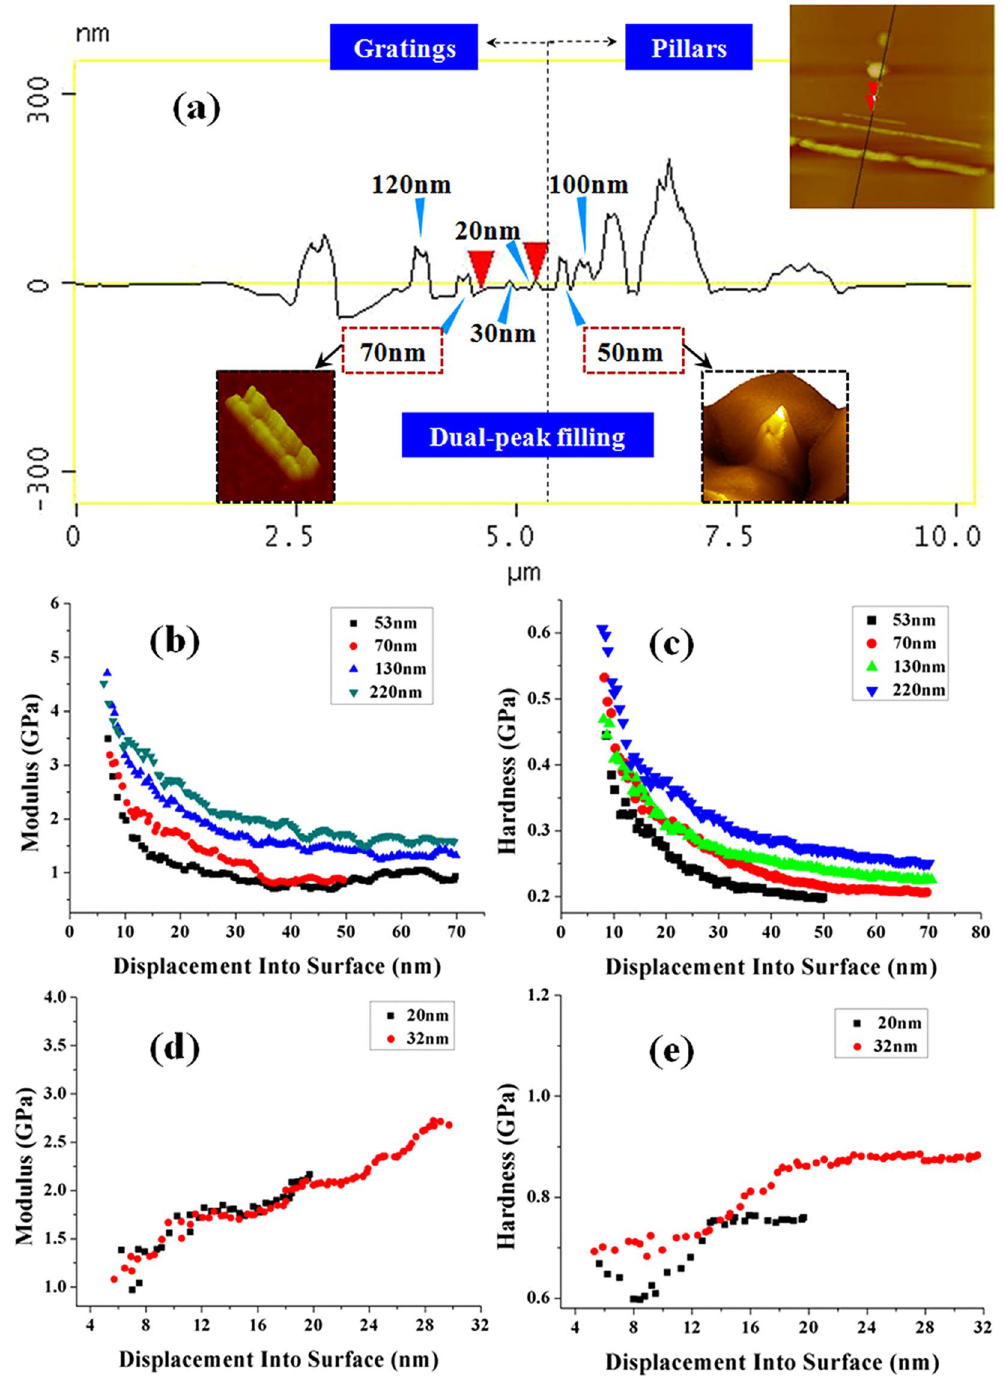
Figure 5. The mechanical behavior of 100 kD PMMA. ( a ) The filling peaks of 100 kD PMMA at the scale from sub-microns to near confinement scale. ( b ) The moduli of 100 kD PMMA at 53 nm, 70 nm, 130 nm, and 220 nm scales. ( c ) The hardnesses of 100 kD PMMA at 53 nm, 70 nm, 130 nm, and 220 nm scales. ( d ) The moduli of 100 kD PMMA at 20 nm and 32 nm scales. ( e ) The hardnesses of 100 kD PMMA at 20 nm and 32 nm